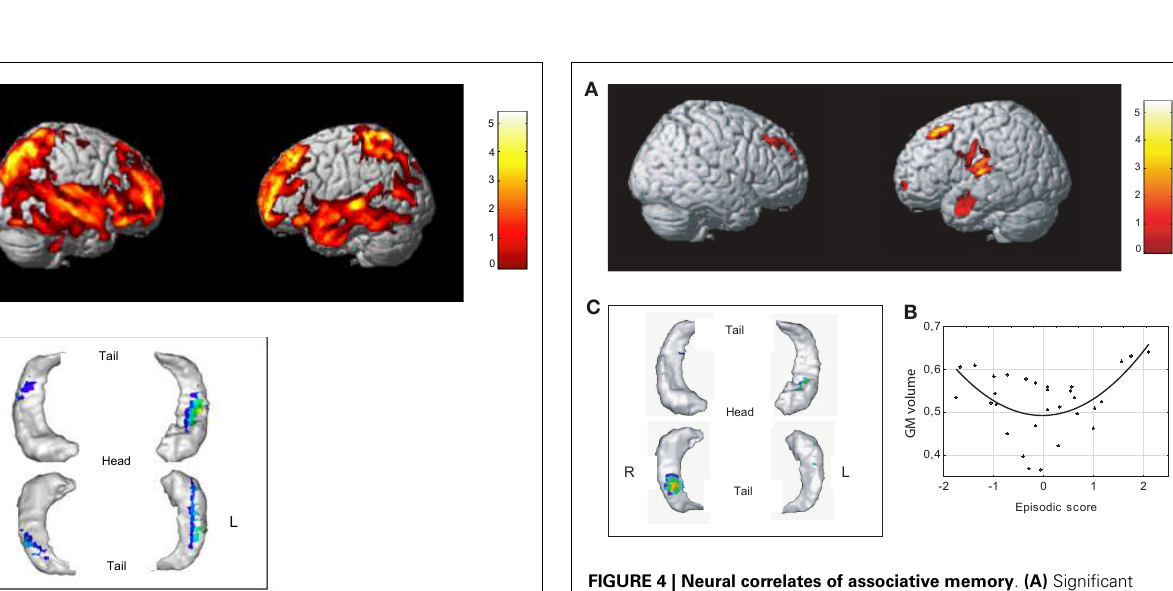
FIGURE 4 | Neural correlates of associative memory . (A) Significant positive correlation (quadratic, U-shaped) with episodic score was found with the volume of gray matter in dorsolateral frontal regions bilaterally, the superior temporal cortex, the anterior middle temporal gyrus, and the ventrolateral prefrontal cortex (upper figure, uncorrected p < 0.001, K > 500). (B) Scatterplots of episodic effects are shown for regions identified in whole brain analyses. (C) Significant positive correlation (quadratic, U-shaped) was observed between memory and right hippocampal body and the anterior part of the left hippocampus (uncorrected p < 0.01, K > 100).